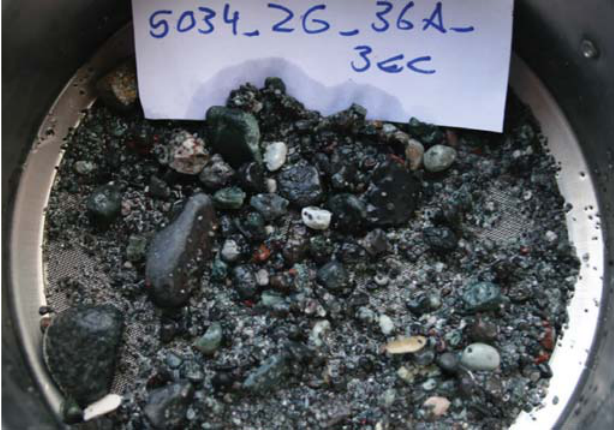
Figure 14. Washed samples of a core catcher of the basal gravel layers. The rounded nature of the gravel indicates coastal or fluvial reworking related to initial lake